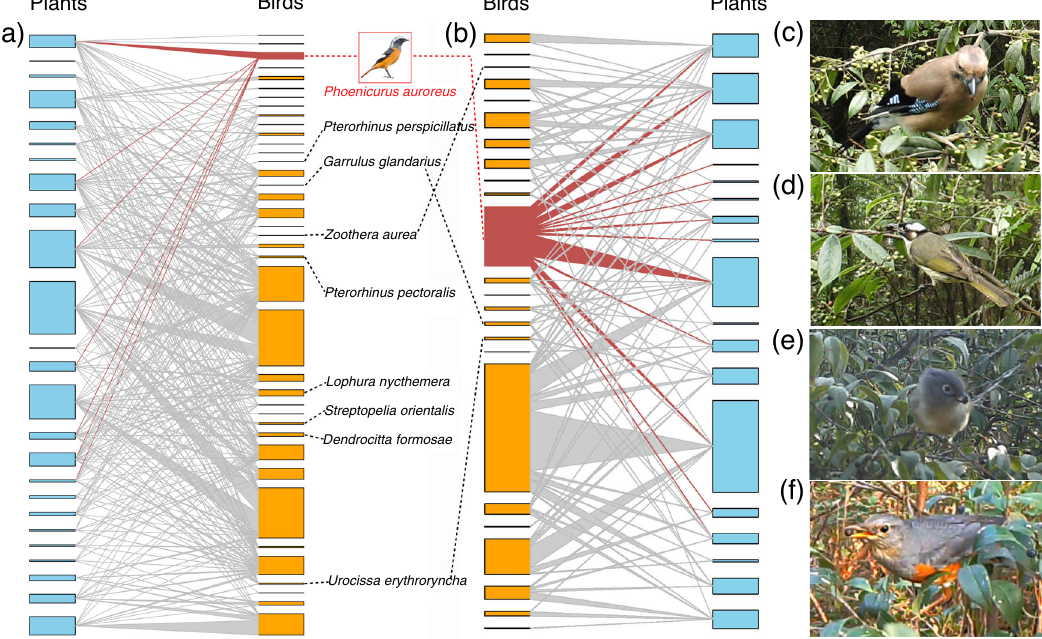
Fig. 2 Illustration of two aggregated plant-frugivore networks and several representative species in the Thousand Island Lake, China. a An aggregated network on the seven largest islands (Islands 01 – 07) and b an aggregated network on the seven smallest islands (Islands 16 – 22). Both networks illustrate the interactions (in grey lines) between avian frugivorous species (in orange) and fl eshy-fruited plant species (in light blue). The widths of the grey lines are proportional to interaction frequencies between species. Scienti fi c names of birds between panels a and b represent eight large-bodied birds higher than 100 g (in black) and one small-bodied bird (in red and illustration with a red border) with high cross-island mobilities. Interactions between Phoenicurus auroreus and fruiting plants are marked red in panels a and b . Representation of several common interacting species in this system: c Eurasian Jay ( Garrulus glandarius ) and d Light-vented Bulbul ( Pycnonotus sinensis ) feeding on Vaccinium mandarinorum . e Huet ’ s Fulvetta ( Alcippe hueti ) feeding on Vaccinium carlesii . f Grey-backed Thrush ( Turdus hortulorum ) feeding on Rhaphiolepis indica